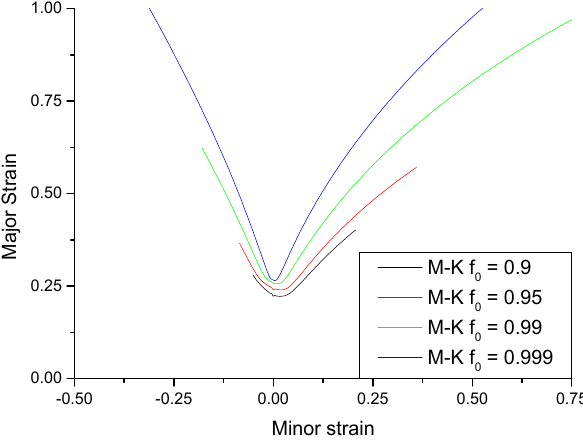
Figure 9. Influence of initial thickness imperfection.